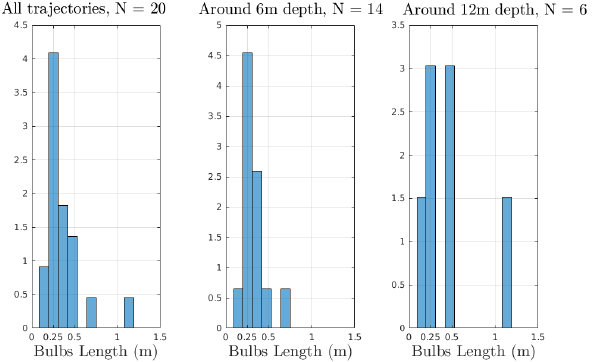
Figure 10. Normalised histograms of the length of